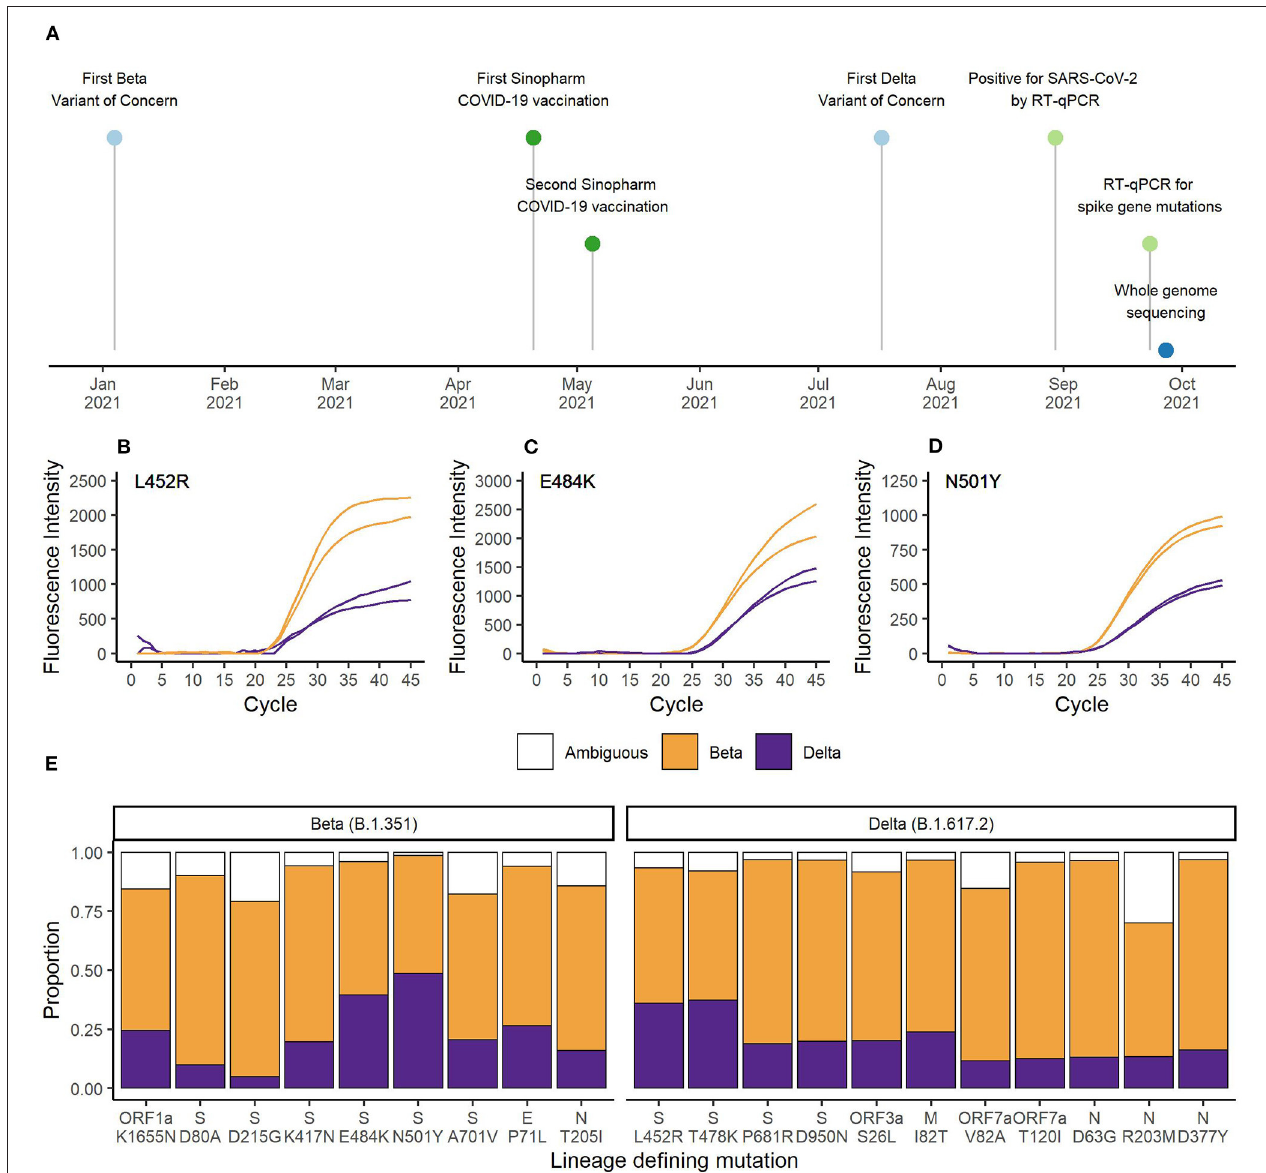
FIGURE 2 | (A) Timeline of vaccination, diagnostic testing and whole genome sequencing. RT-qPCR results for the spike gene mutations (B) L452R, (C) E484K, and (D) N501Y. Orange represents the curves matching Beta VOC (L452, 484K, and 501Y) and purple represents the curves matching Delta VOC (452R, E484, and N501) defining SNPs. (E) Proportion of sequencing reads matching Beta or Delta VOC for the lineage defining mutations. Orange bars represent Beta VOC and purple bars represent Delta VOC. White bars represent the proportion of reads matching neither Beta nor Delta